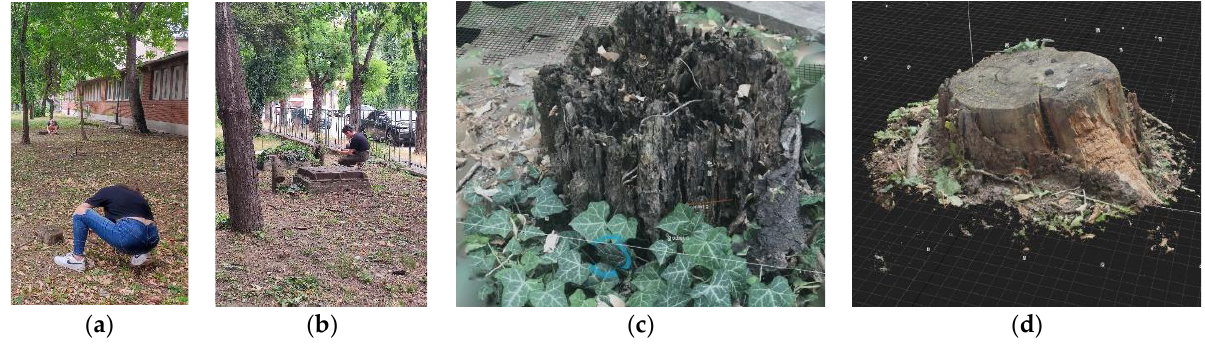
Figure 5. Students photographing outdoor elements and first good results ( a ) Location; ( b ) Details about structures; ( c ) Real wood piece; ( d ), Reconstruction.